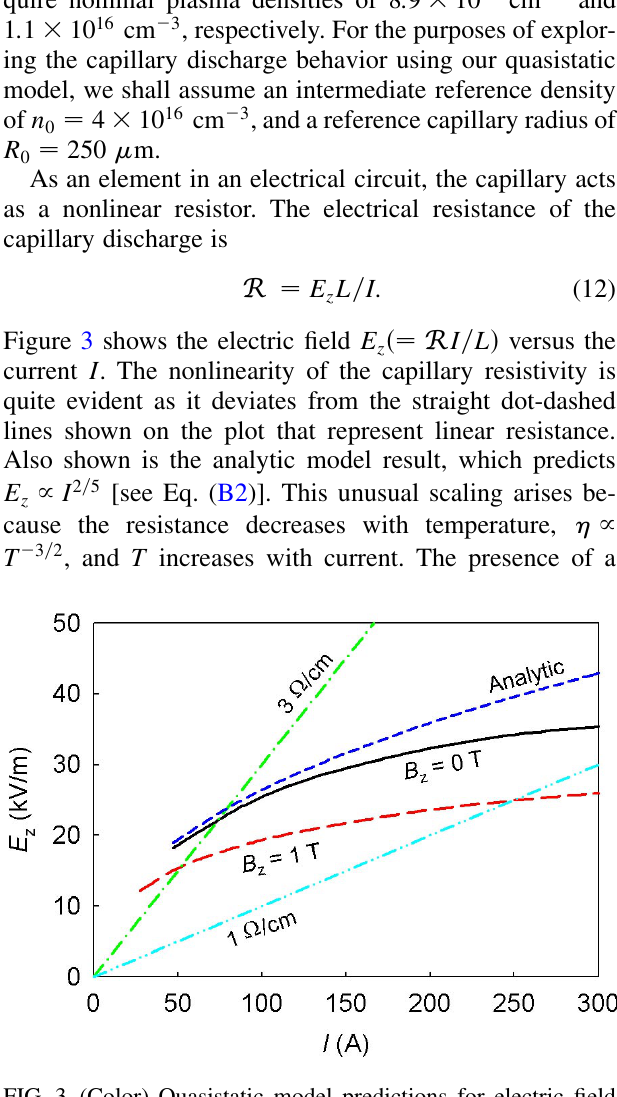
FIG. 3. (Color) Quasistatic model predictions for electric field (cid:7) gradient versus the capillary discharge current with R 0 (cid:7) 4 (cid:6) 10 16 cm (cid:3) 3 . B is the external solenoid 250 (cid:2) m and n z 0 field.